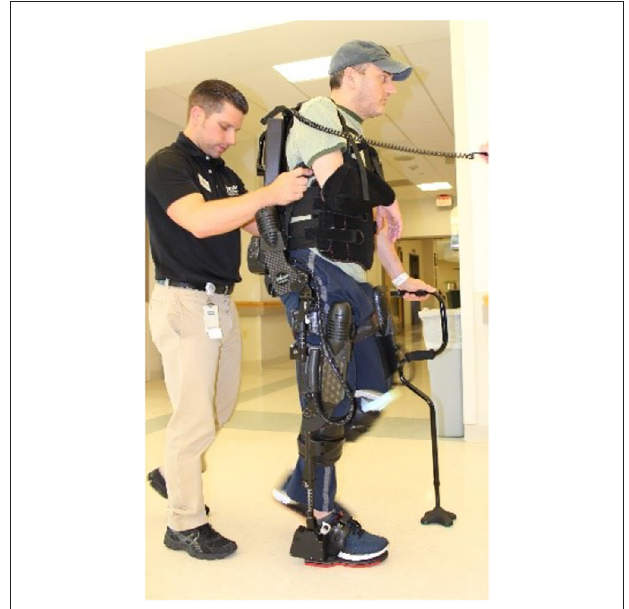
FIGURE 1 | Robotic Exoskeleton (RE) gait training with a physical